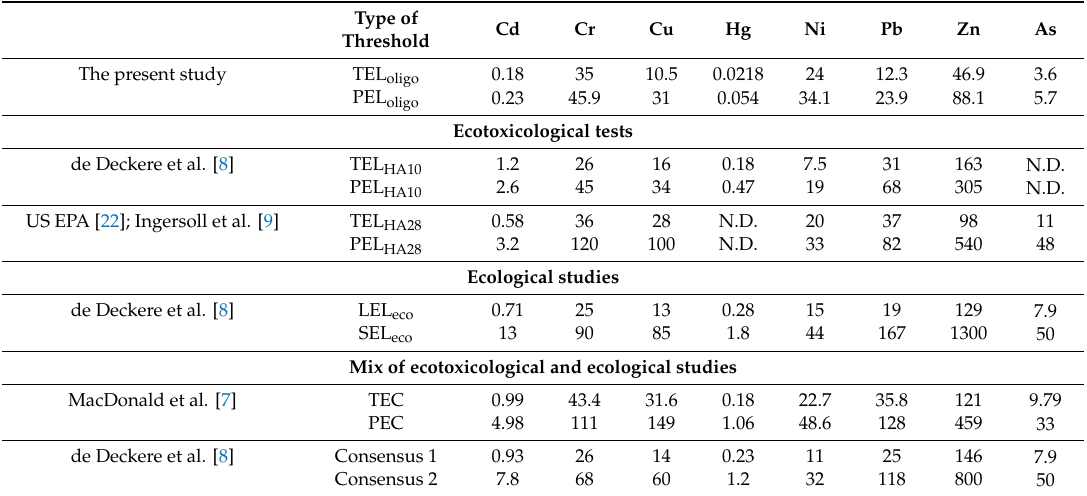
Table 5. Comparison between the e ff ect thresholds derived in the present study (TEL oligo , PEL oligo ) and those proposed in previous studies based on ecological data and ecotoxicological tests with field-collected